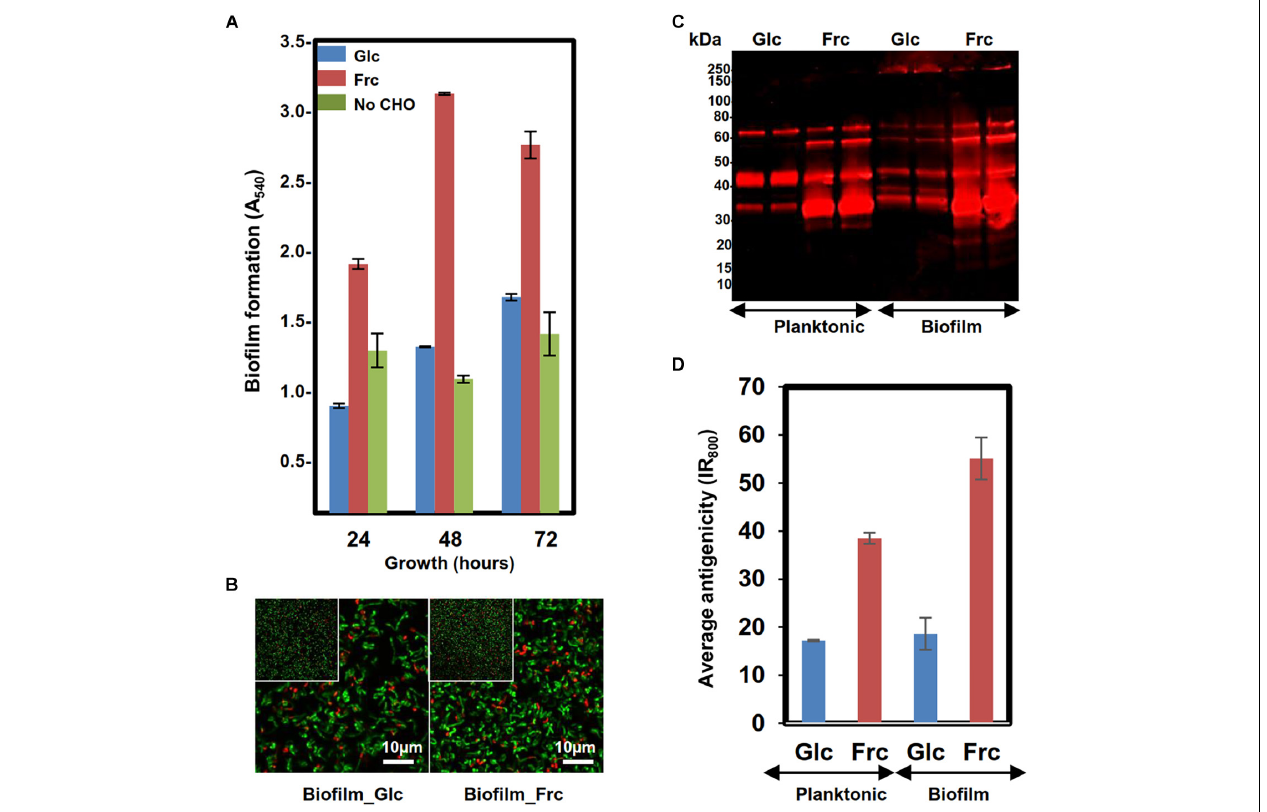
FIGURE 1 | Assessing the biofilm formation of the GG cells in MRS in the presence 2% glc, 2% frc or without carbohydrate (CHO) under anaerobic conditions (5% CO 2 ). (A) Biofilm formation efficiency of the GG cells in the presence of frc and glc on flat-bottom polystyrene wells at indicated time points of incubation. (B) Fluorescence images of 48 h old biofilms prepared in the presence of glc and frc. Biofilms were stained with the LIVE/DEAD Bac Light kit with Syto9 for staining viable cells and PI for dead cells. The scale bar is 10 µ m. (C) 1-DE immunoblot analysis of planktonic and biofilm GG cells using anti-GG antibodies targeting the surface-associated proteins. The surface proteins were isolated from 24 h old (planktonic) and 48-h-old (biofilms) cells, and the amounts of samples separated by 1-DE were normalized to cell density. Glc and Frc indicate lanes with samples (two technical replicate) grown in presence of glucose and fructose, respectively. The antigen profiles were detected using an Odyssey R (cid:13) infrared imaging system. (D) Total fluorescence of each 1-DE antigen profile was quantified using the AlphaImager gel documentation and image analysis